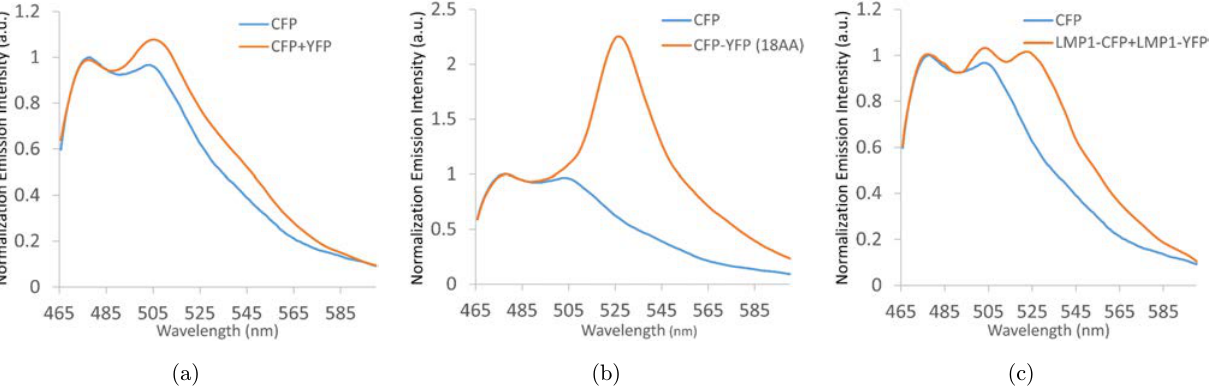
Fig. 4. Fluorescence spectra of CNE1 cells expressing fusion proteins. (a) CNE1 cells co-transfected with CFP and YFP plasmids, (b) transfected with CFP-YFP plasmids (18AA) and (c) co-transfected with LMP1-CFP and LMP1-YFP plasmids. All spectra were normalized as percentage of CFP maximal emission peak. These spectra were representative of three independent